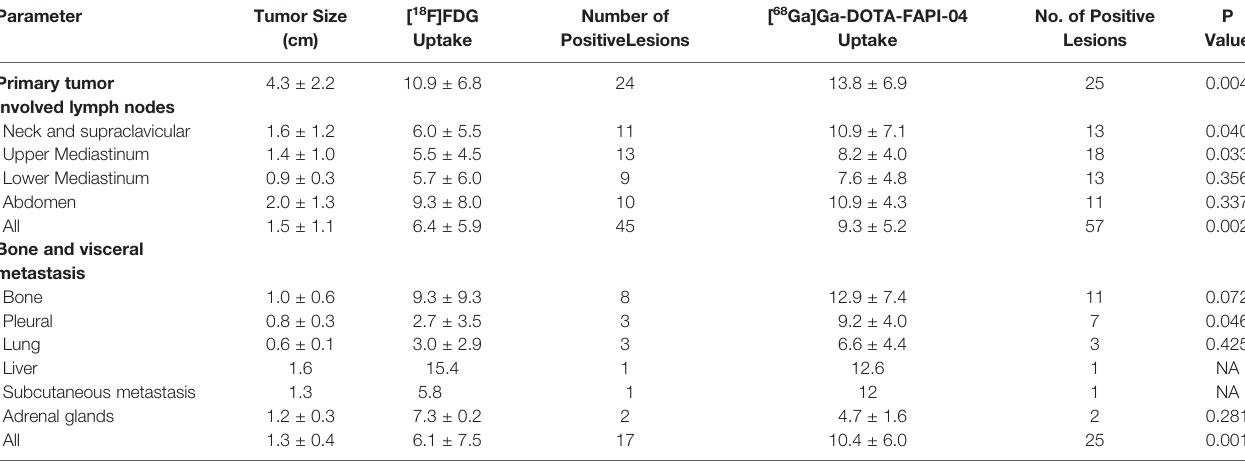
Frontiers in Oncology |